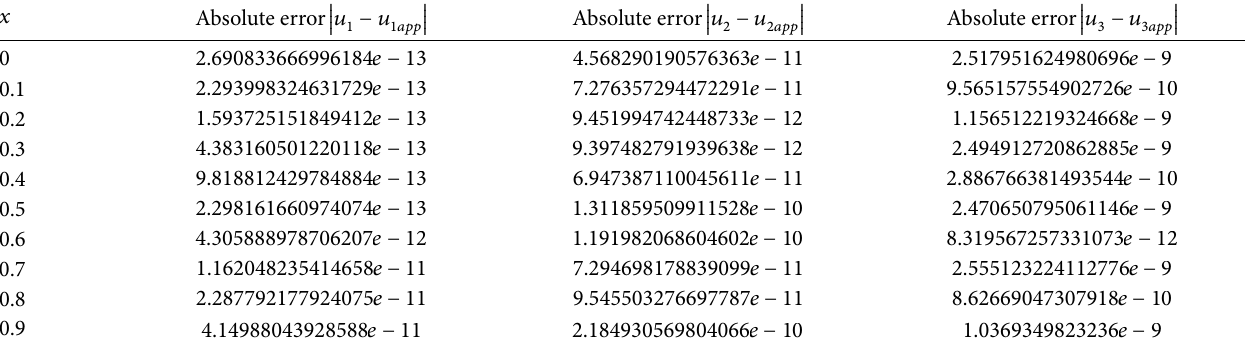
Table 4: The resulting error for the numerical solution.